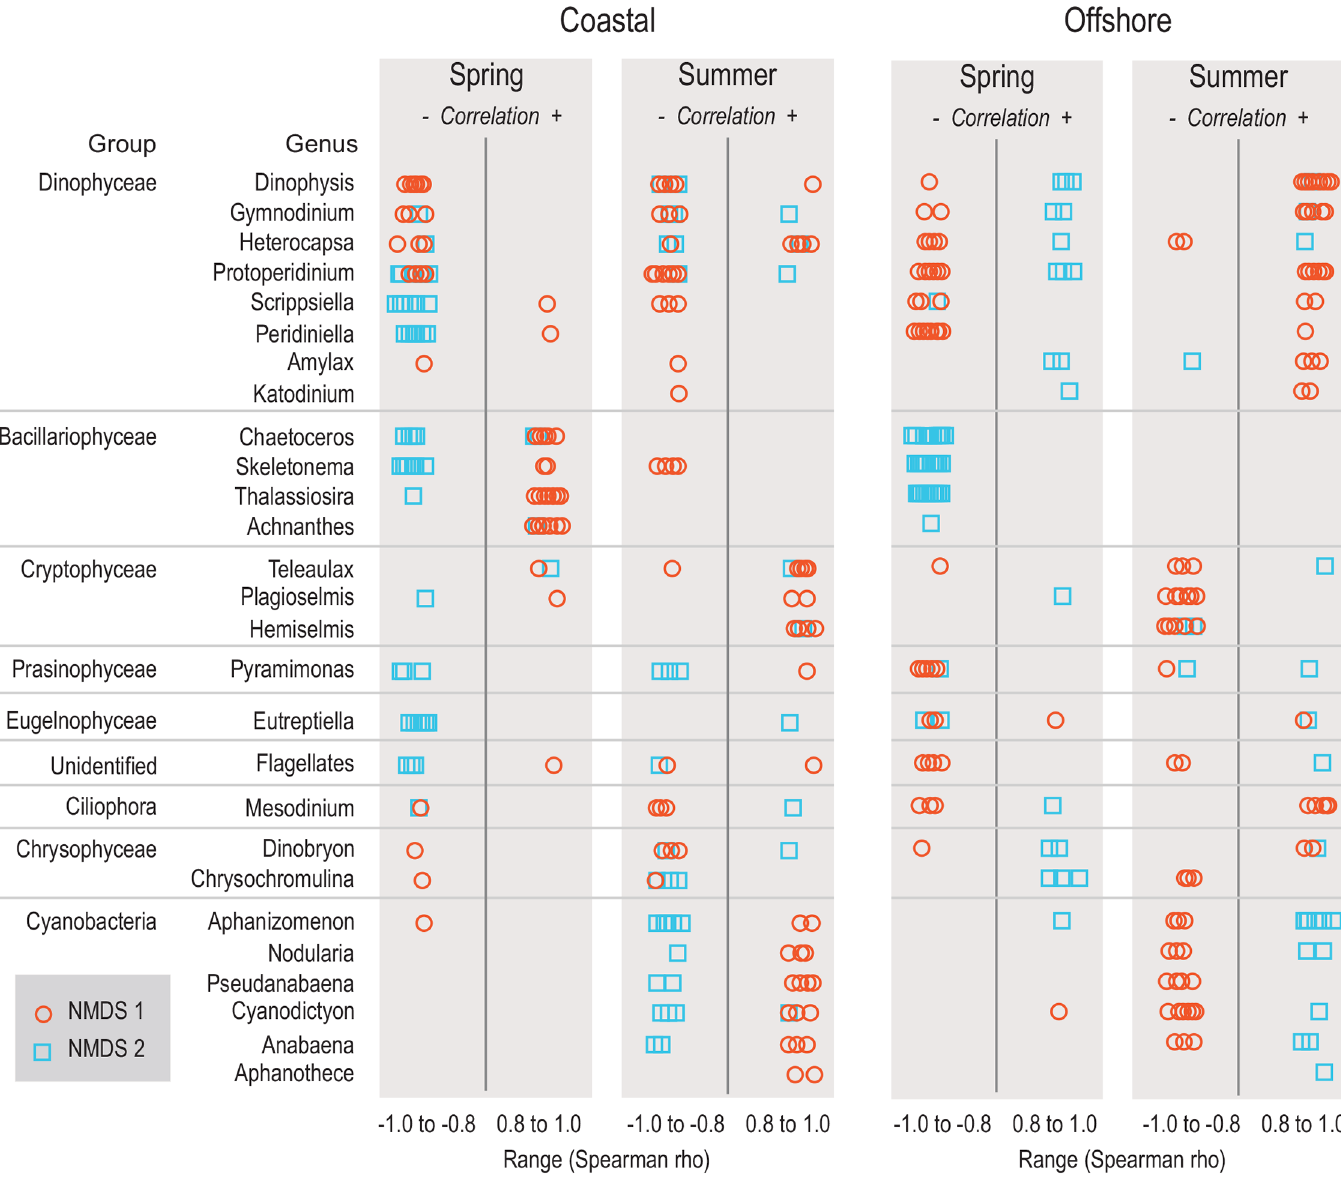
Fig 6. Species correlations with multivariate patterns. Score plots showing contributions of phytoplankton species to temporal trajectories of phytoplankton community dynamics identified by NMDS during spring and summer at the coastal and offshore site, based on Spearman rank correlation analyses. Only taxa with significant correlations with NMDS dimensions (P < 0.05) and high correlation coefficient (Spearman´s rho > 0.8) are shown. For better visibility taxa are aggregated to genus